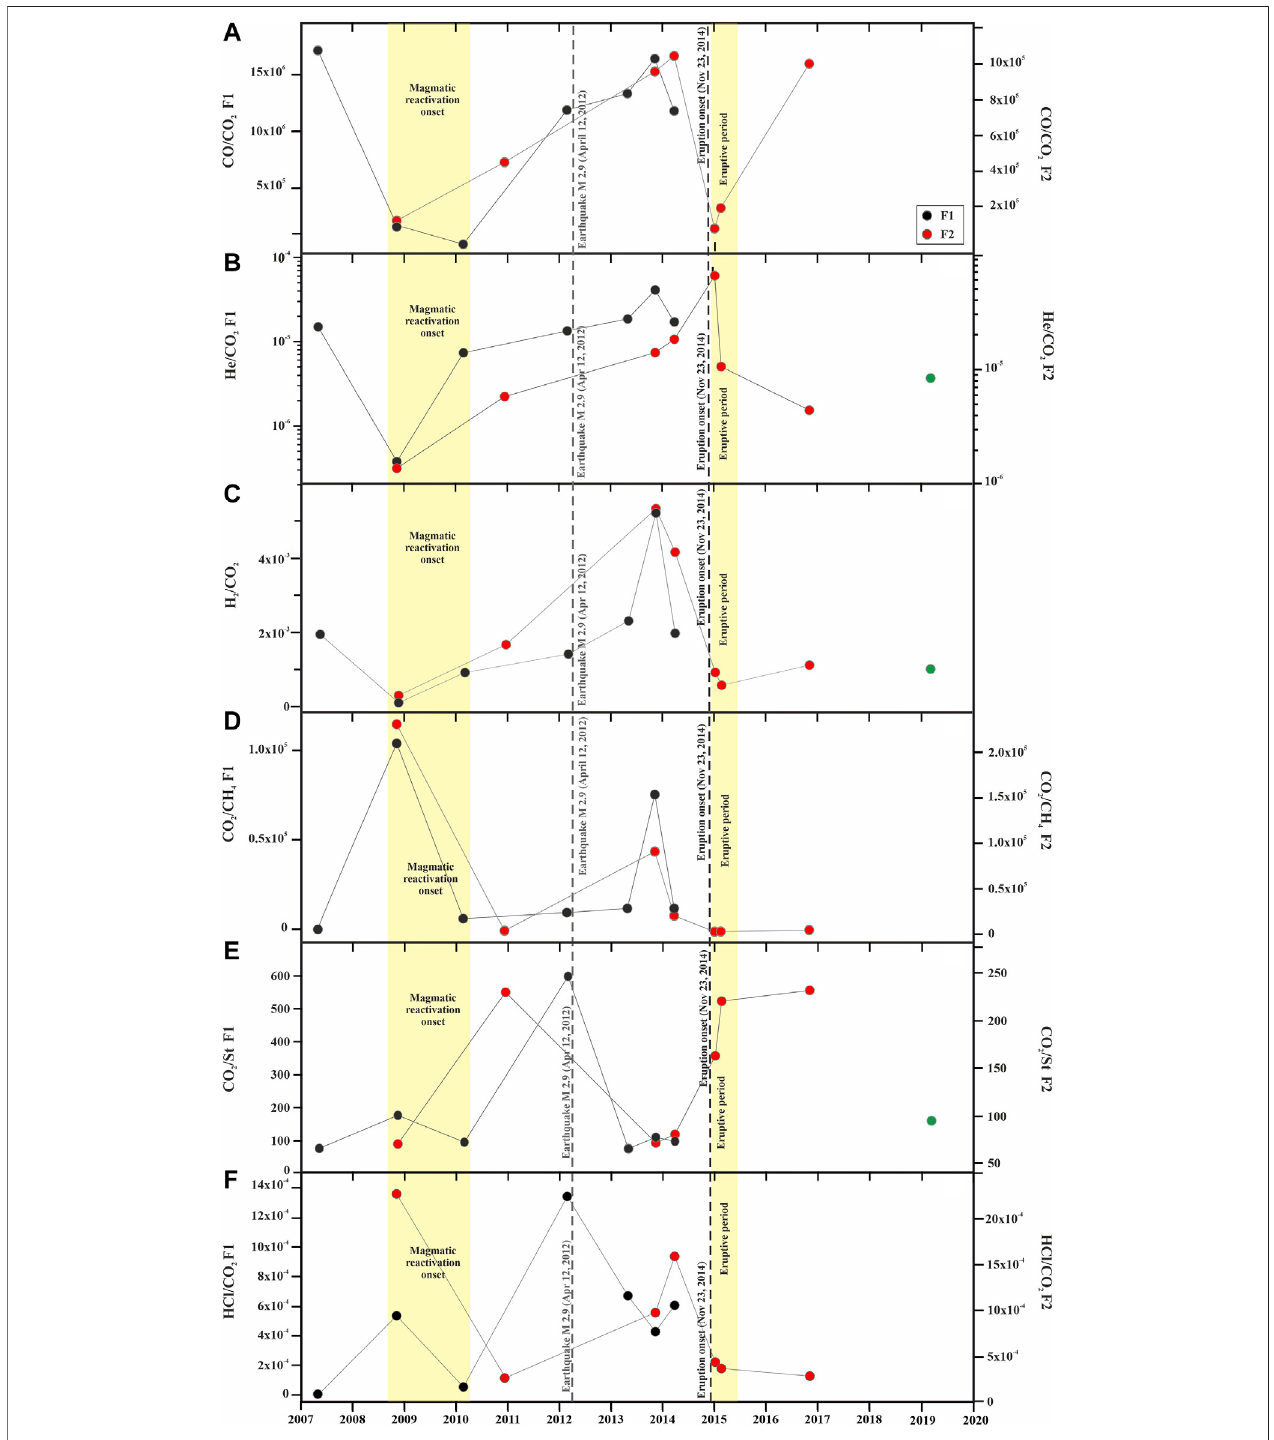
FIGURE10| Temporalevolutionof (A) CO/CO 2 , (B) He/CO 2 , (C) H 2 /CO 2 , (D) CO 2 /CH 4 , (E) CO 2 /S total (F) HCl/CO 2 ,ratiosmeasuredinthePicodoFogoF1andF2 fumarole discharges. The green dot represents data from Aiuppa et al. (2020).